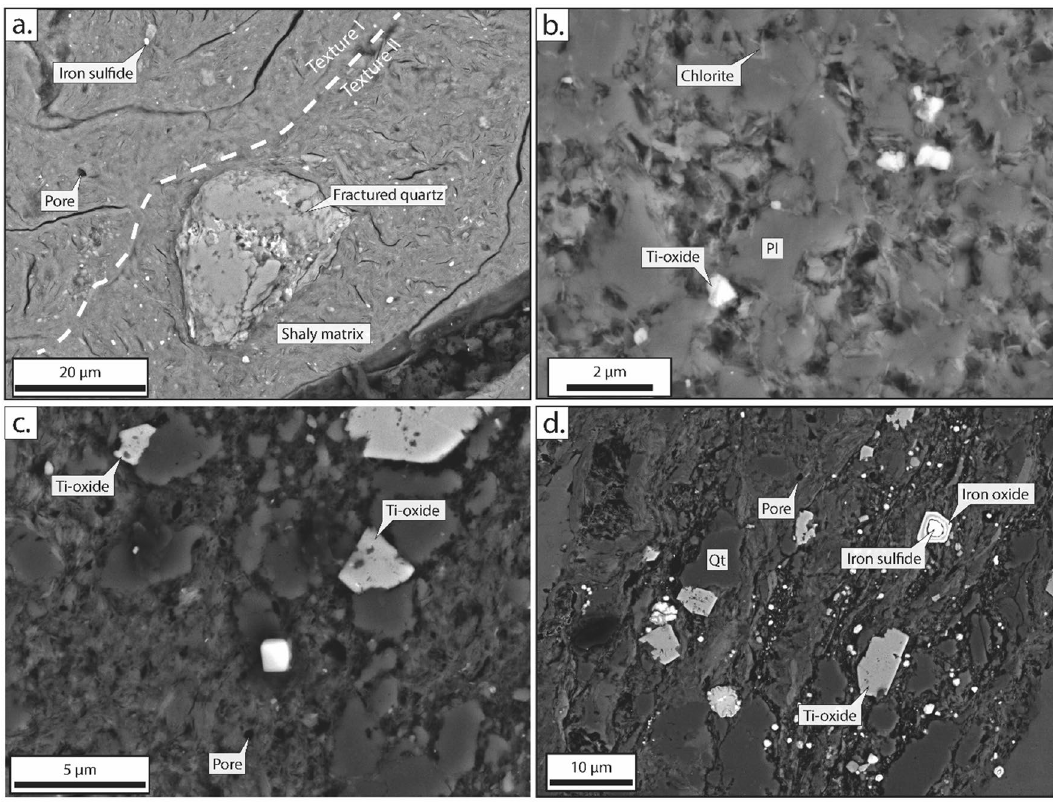
Figure 3. SEM illustrations of the microstructures observed in the Black Fault Rocks and its host-rock. ( a ) Fractured quartz in a shaly matrix containing scattered iron sulfides and pores and showing two textures defining layering ; ( b ) (Sub)euhedral titanium oxides in a Black Fault Rock composed of plagioclase clasts and a chlorite matrix ( c ) Shaly matrix of the Black Fault Rock containing euhedral titanium oxides and pores ( d ) Host-rock shaly matrix containing quartz clasts and iron sulfides replaced by titanium oxides on the rim Location ( a ), Nobeoka Black Fault Rock; ( b ) Kodiak Black Fault Rock; ( c , d ) Okitsu Black Fault Rock. Qt quartz, Pl